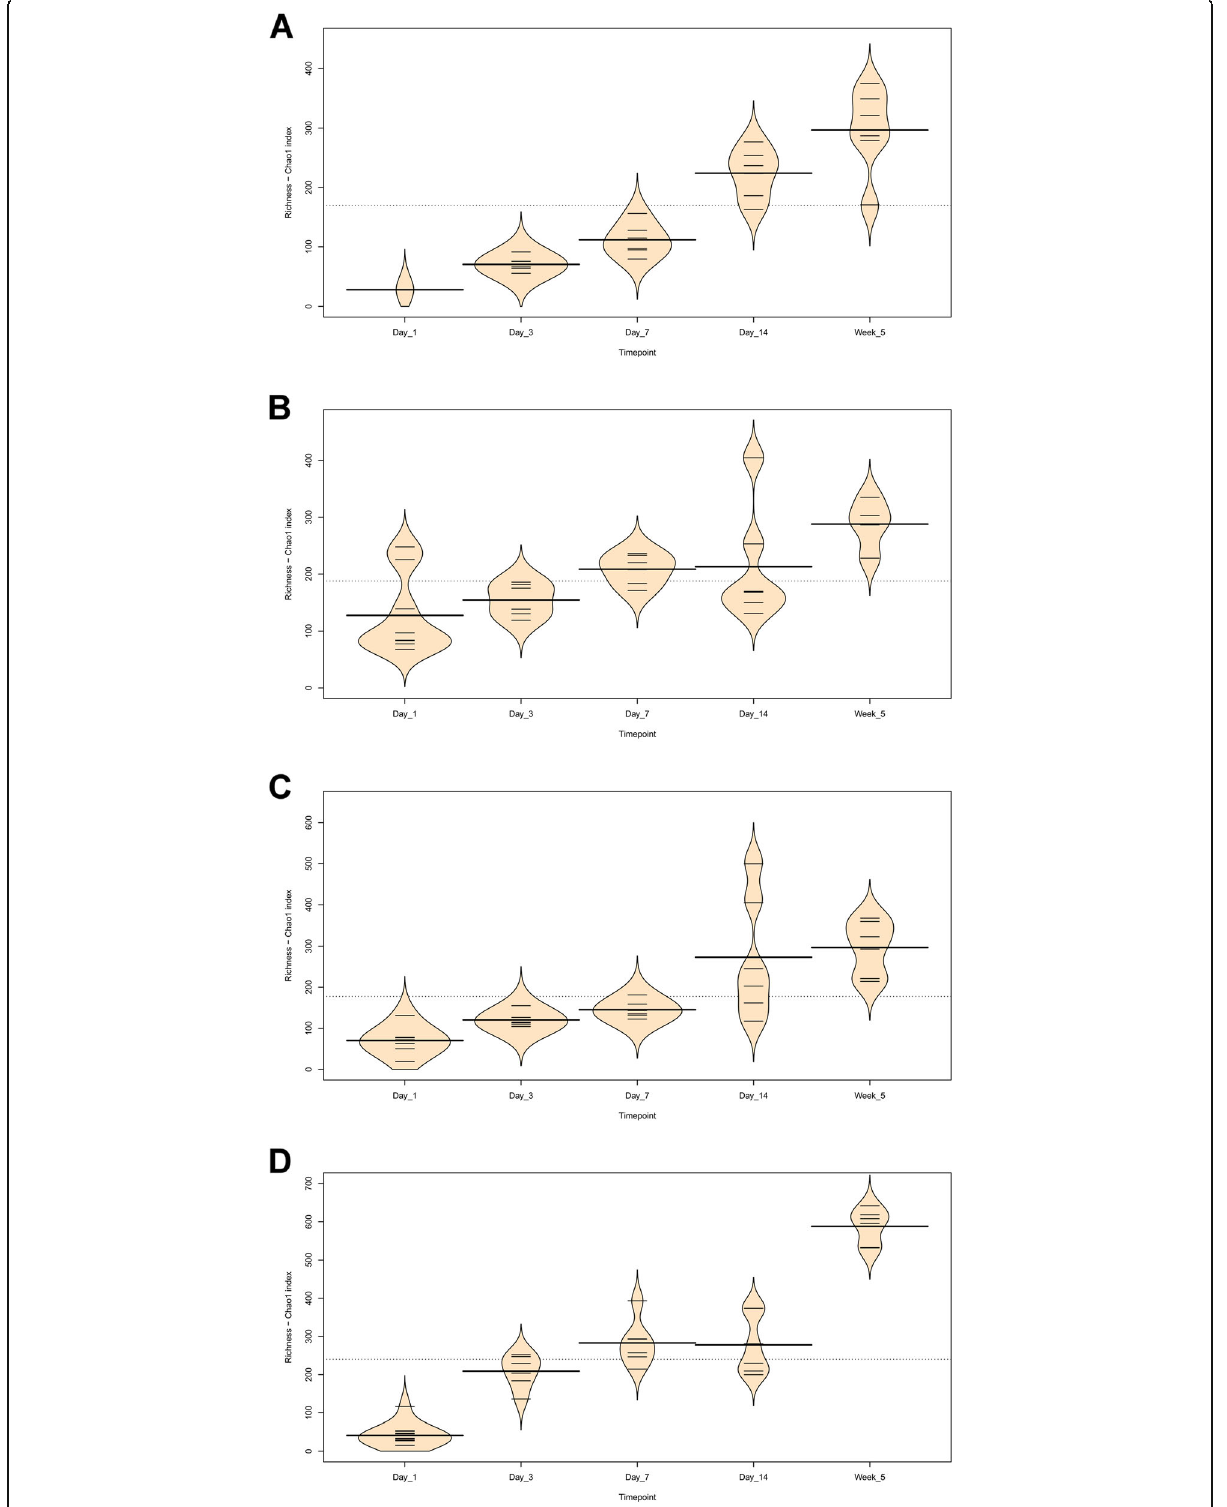
Fig. 5 Beanplots showing richness (Chao1 Index) of chicken intestinal microbiota communities across timepoints (subsampled to 10,000 reads). Small bars represent individual data points while the wider line within each timepoint represents the mean. a ) Duodenum b ) Jejunum c ) Ileum d )